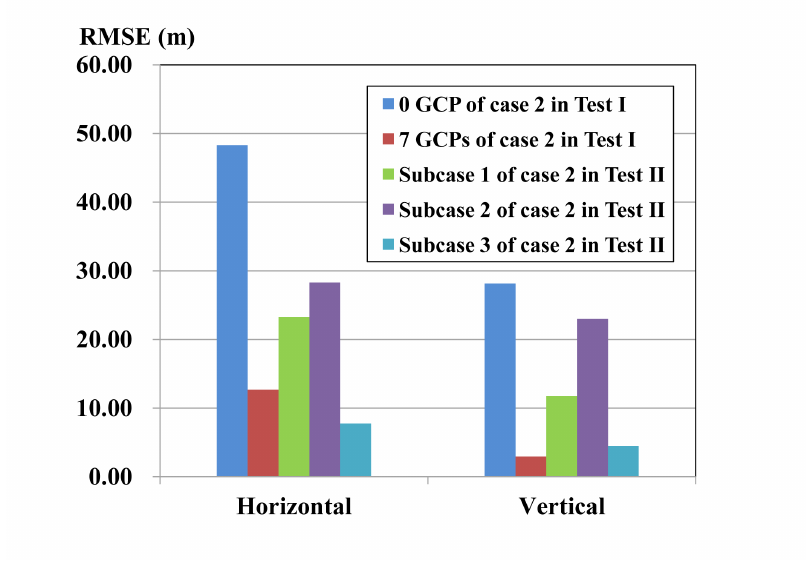
Figure 8. Accuracy comparison between Case 2 of Test II and Test